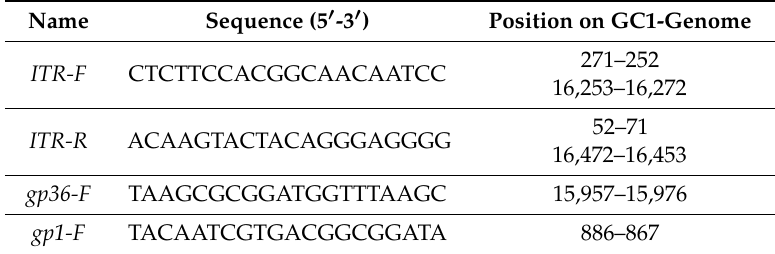
Table 3. Primers used in the